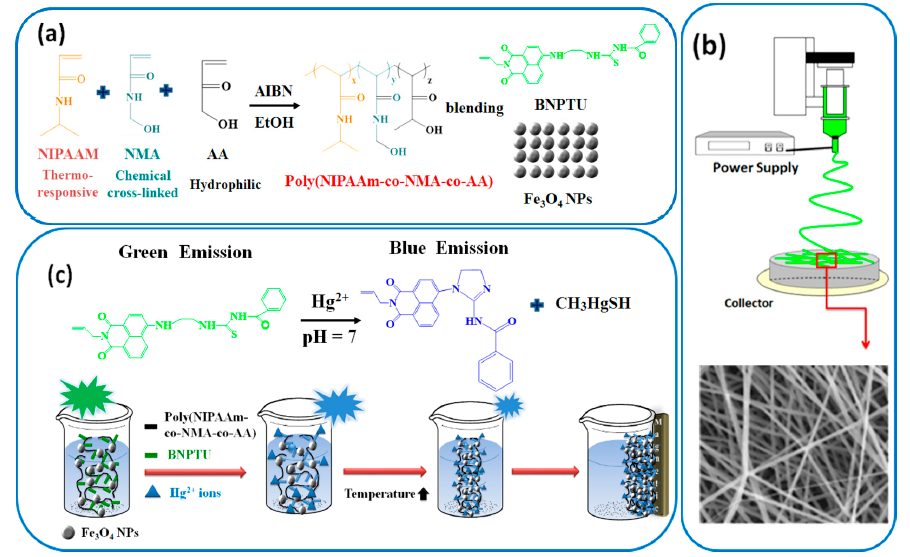
Figure 2. Design of multifunctional sensory electro spun (ES) nanofibers synthesized from poly(NIPAAm- co -NMA- co -AA), BNPTU, and Fe 3 O 4 blends with magnetic fluorescence